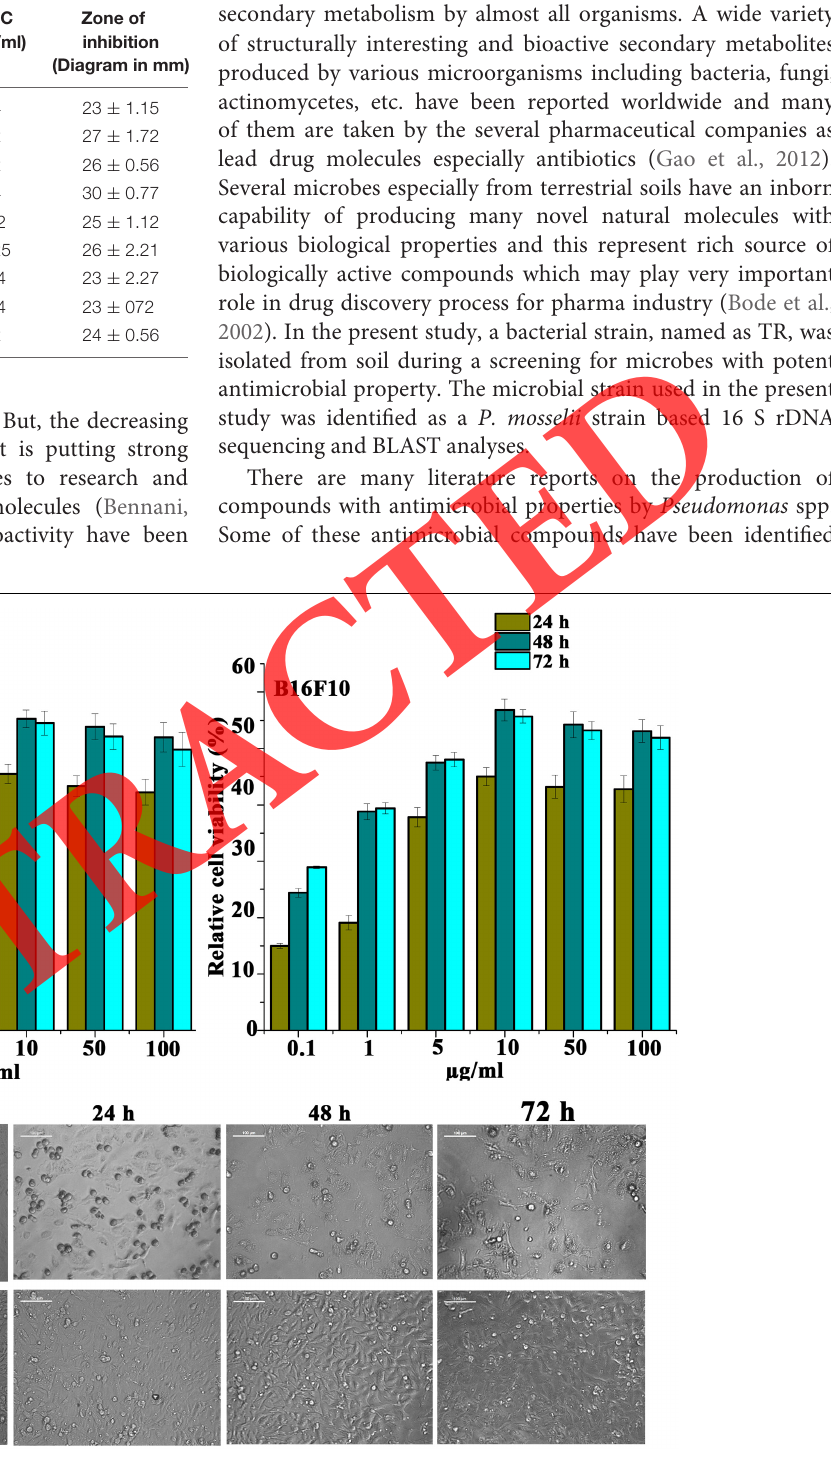
Frontiers in Microbiology |